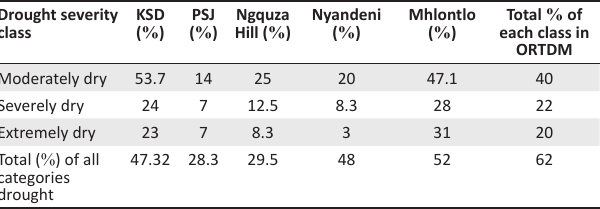
TABLE 4 : Drought severity class table for OR Tambo District Municipality and all its local municipalities for 6 months moving standardised precipitation index during